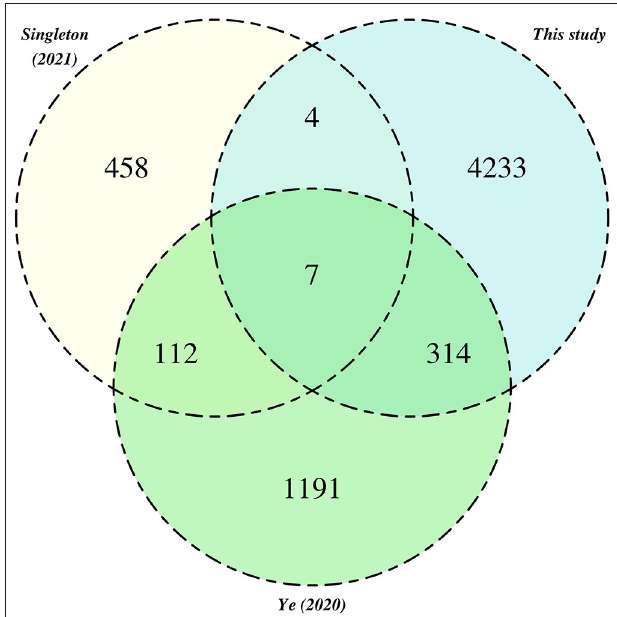
FIGURE 6 | Relationships between pHQ-MAGs recovered in this study and MAGs from extant activated sludge catalogs. Counts reference secondary clusters categorised by the presence of MAGs originating from one of the three MAG